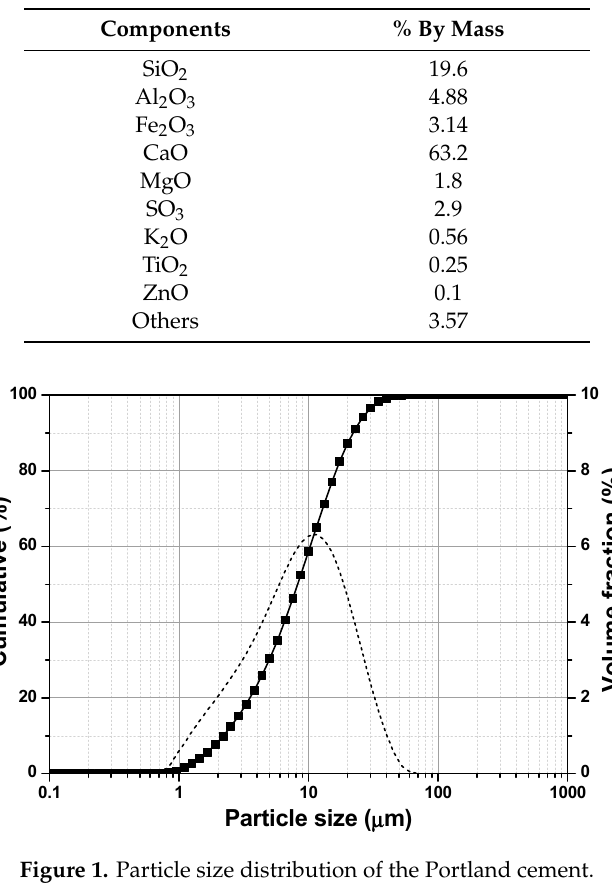
Table 1. Chemical composition of Portland cement [14].